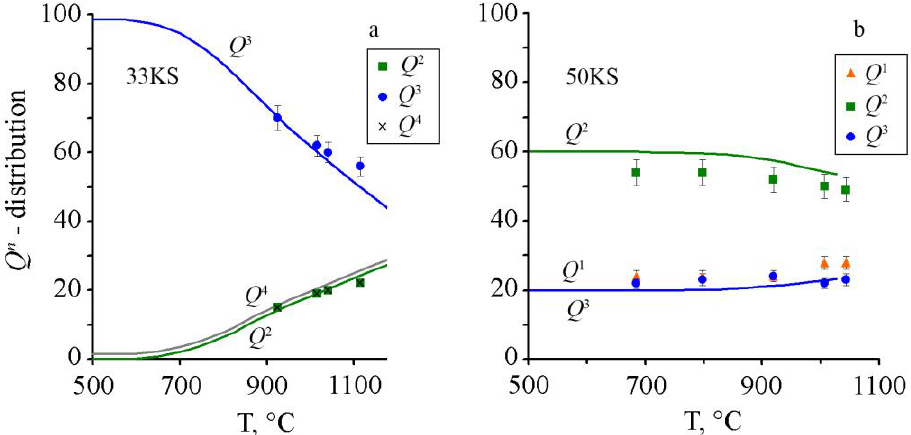
Figure 5. Results of modeling 33KS ( a ) and 50KS ( b ) melt structure depending on temperature. Points are experimental data from Raman spectroscopy; lines are simulation results.